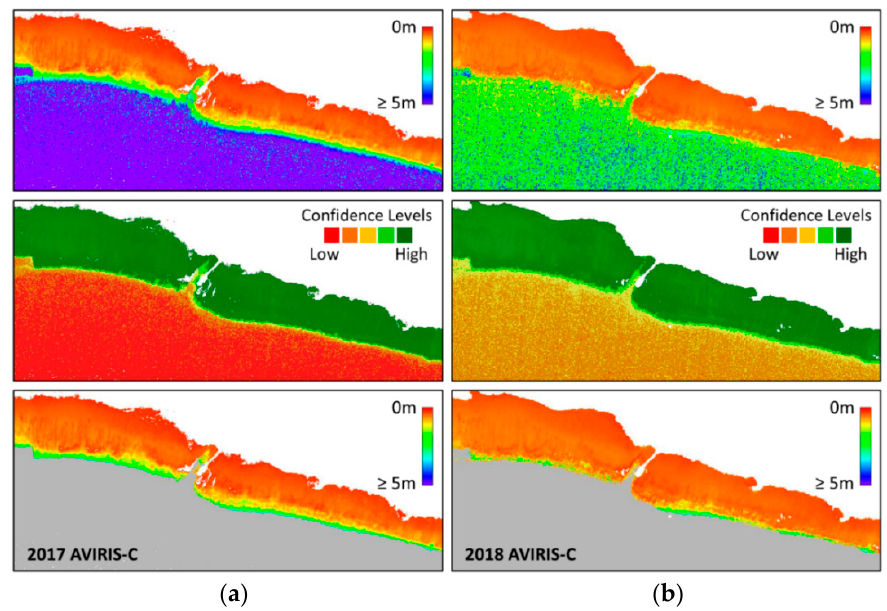
Figure 8. Example application utilizing confidence levels to subset high-confidence output for AVIRIS-C derived bathymetry at 18 m spatial resolution, including (top to bottom) derived bathymetry, confidence levels, and high-confidence derived bathymetry: ( a ) 2017 Molokai; ( b ) 2018 Molokai. Areas with no data and masked areas of land, cloud, cloud shadow, and wave breaks are shown in white. Areas masked by lower three confidence levels are shown in grey.